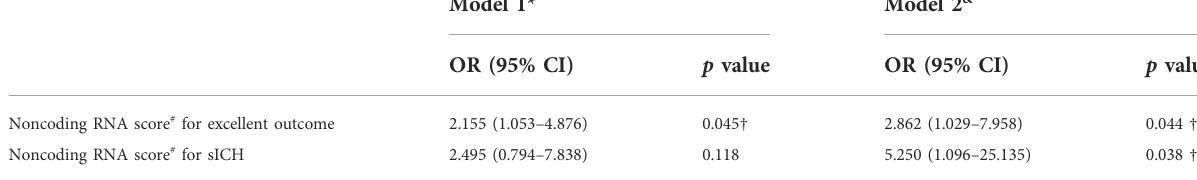
Noncoding RNA score # for excellent